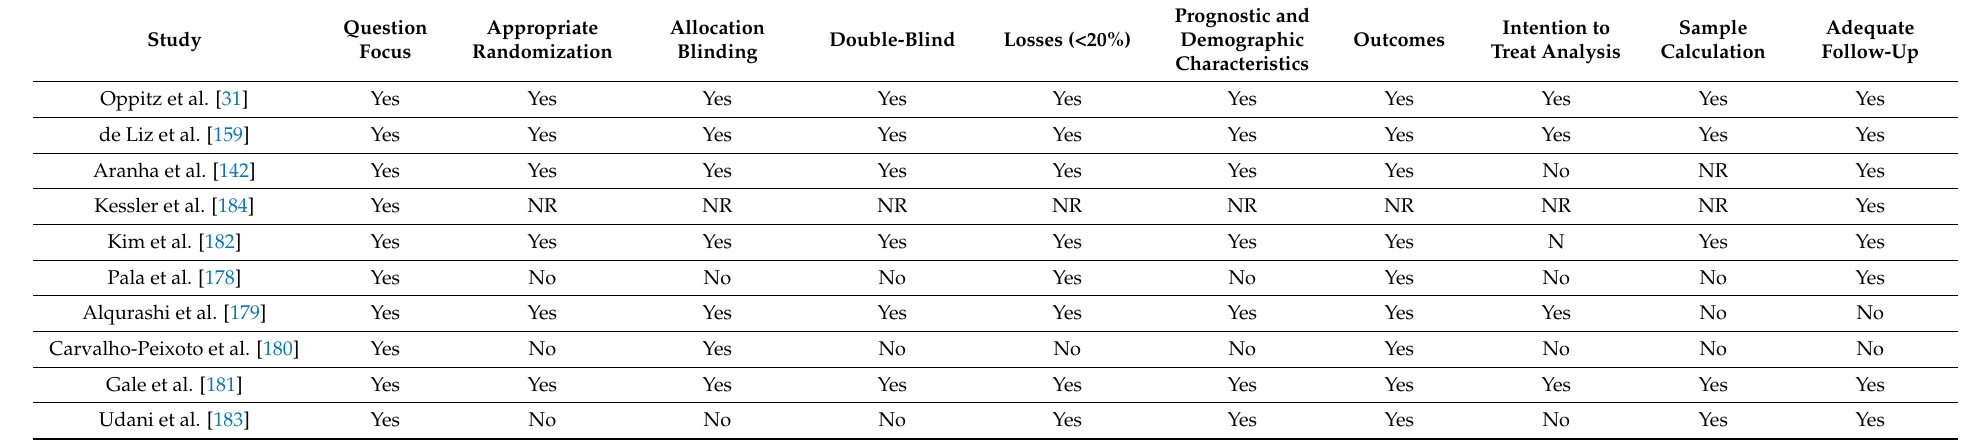
Table 4. Descriptive biases presented by the included clinical trials performed with aça í